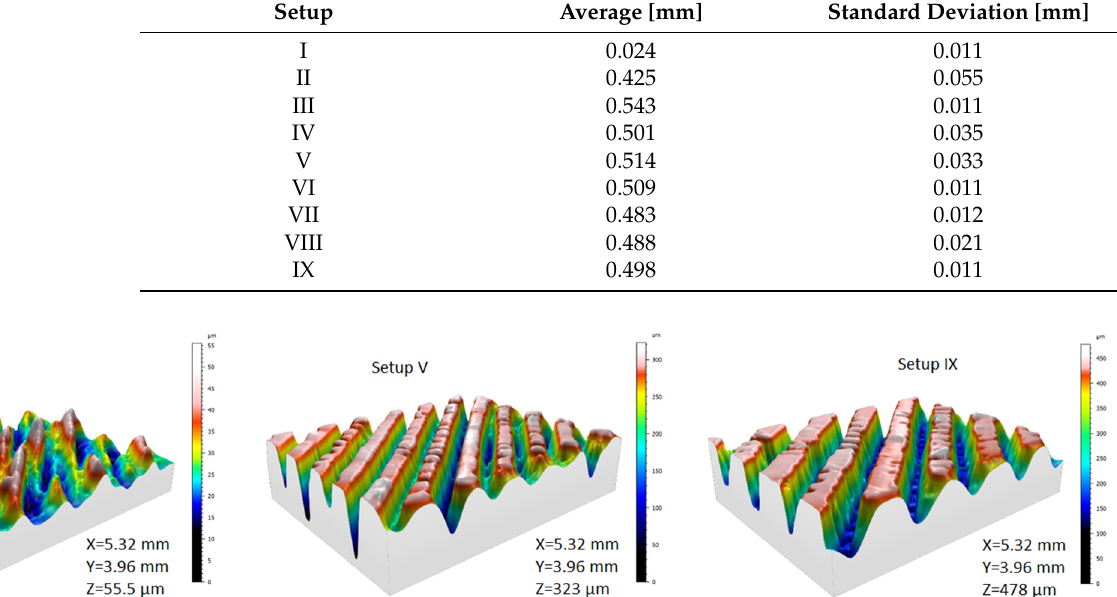
Table 5. Coating thicknesses (average and standard deviation). Figure 4. Flowchart of the research framework.